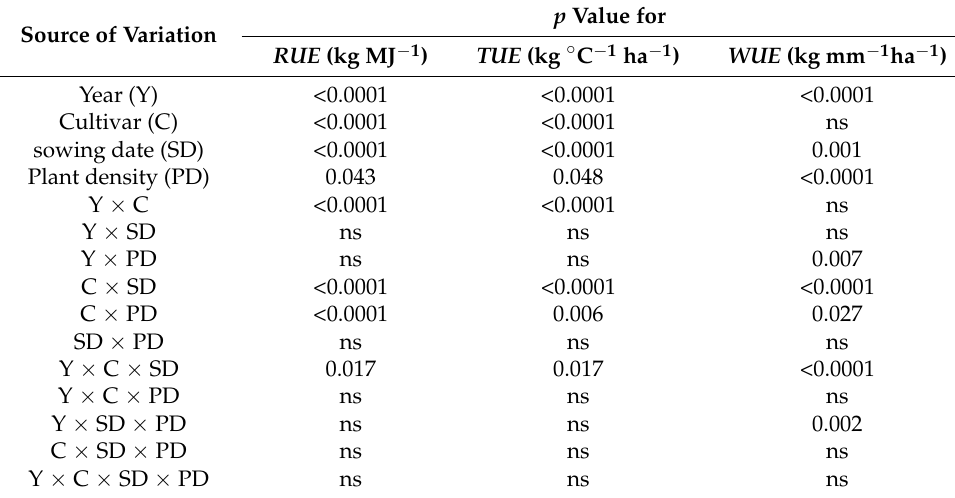
Table 5. Analysis of variance on RUE , TUE , and WUE